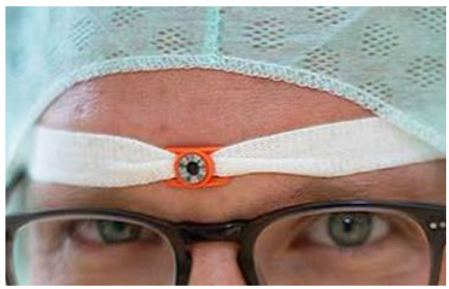
Figure 1. Way of wearing the eye dosimeter.